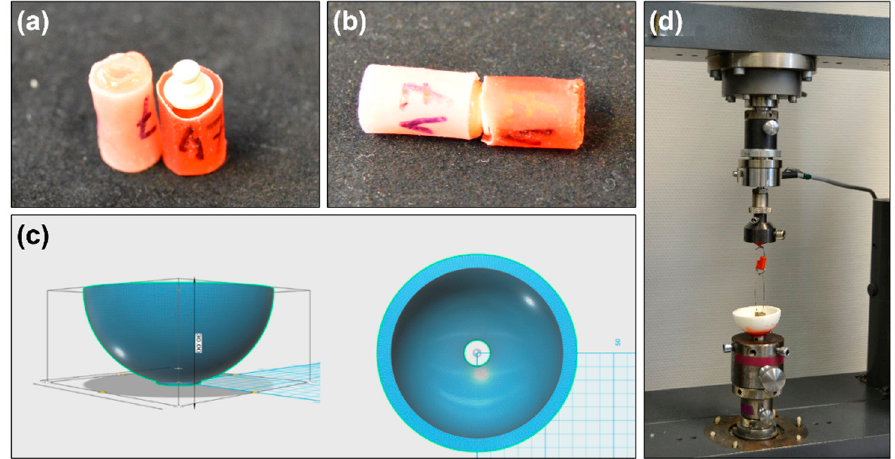
Figure 3. Experimental set-up of the universal testing machine. ( a , b ) Specimens of experimental samples after the aging treatment; ( c ) a container for artificial saliva designed by CAD; ( d ) the universal testing machine with an FDM 3D-printed container.